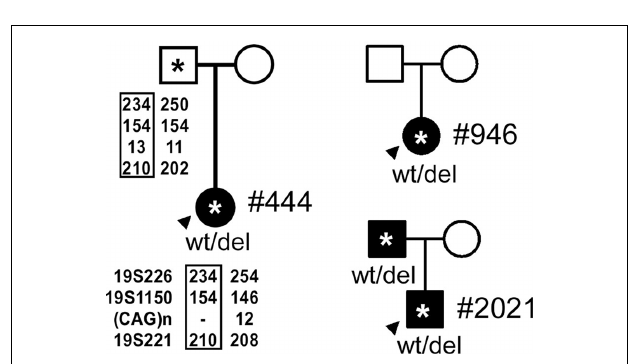
FIGURE 1 | Newly identified and previously reported EA2-causing genomic rearrangements in CACNA1A that vary in size and location. In a diagram of the genomic structure of CACNA1A on chr 19 spanning approximately 300, 000 base pairs (shaded in gray), the vertical bars represent exons, and those in red harbor target sequences for the MLPA probes.The locations of exons 1, 4, 38, and 47 are specified.The rectangles highlighted in blue below the genomic structure of CACNA1A represent